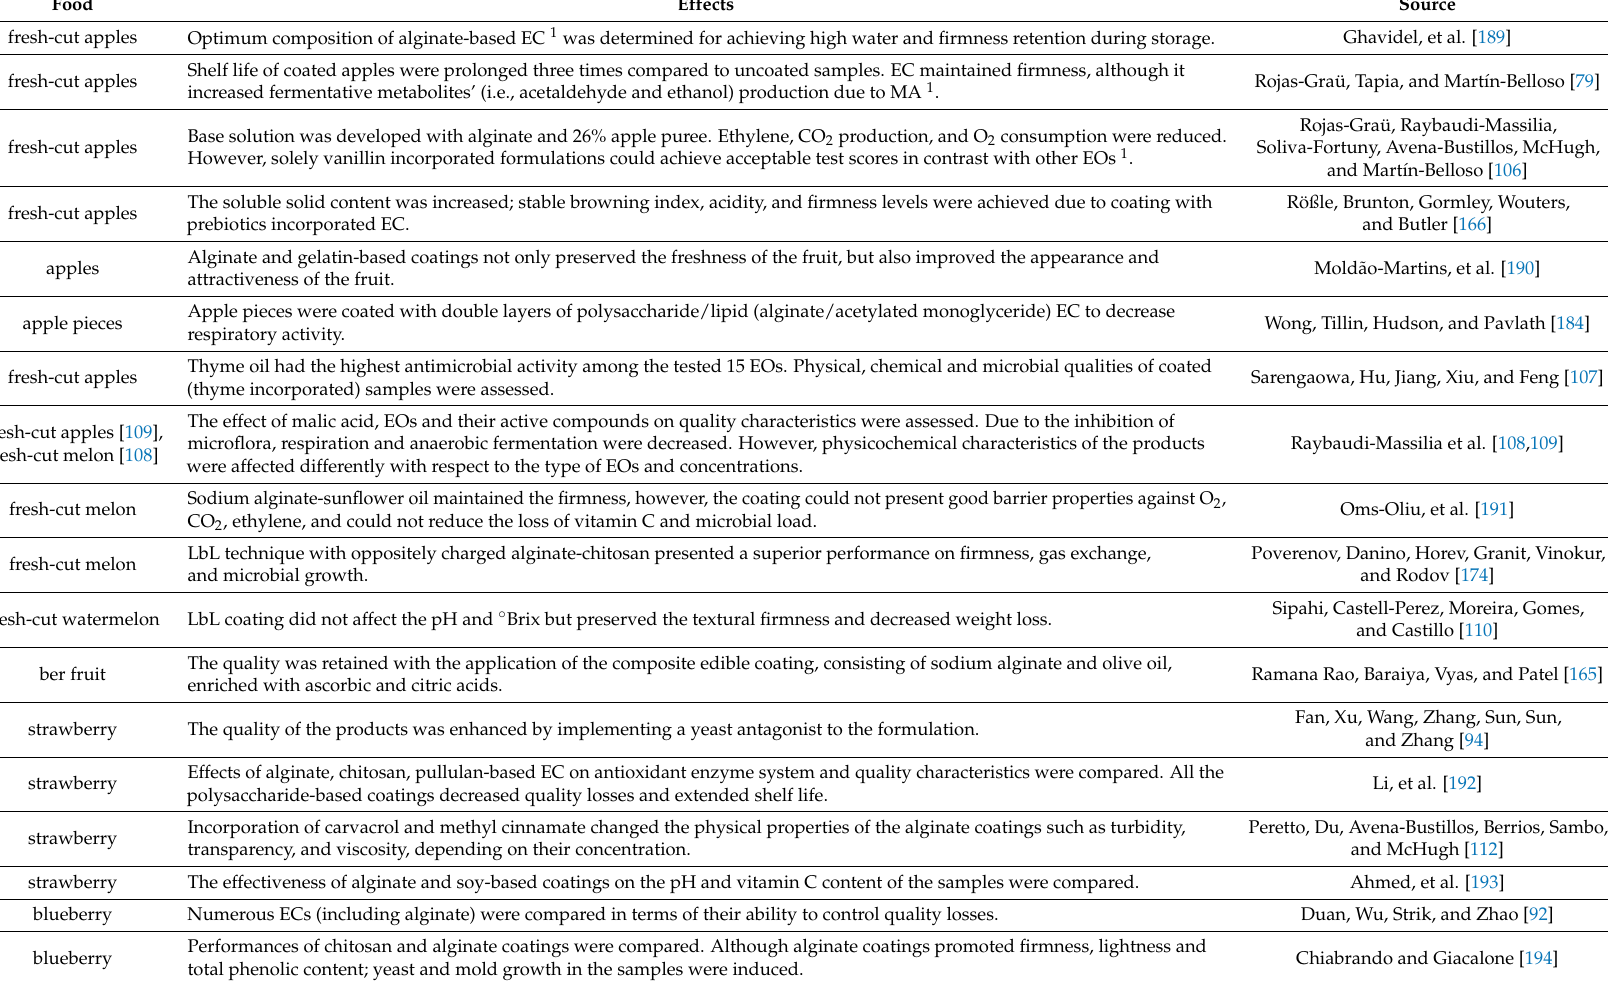
Table 3. The application of alginate coatings on fresh-cut fruits and